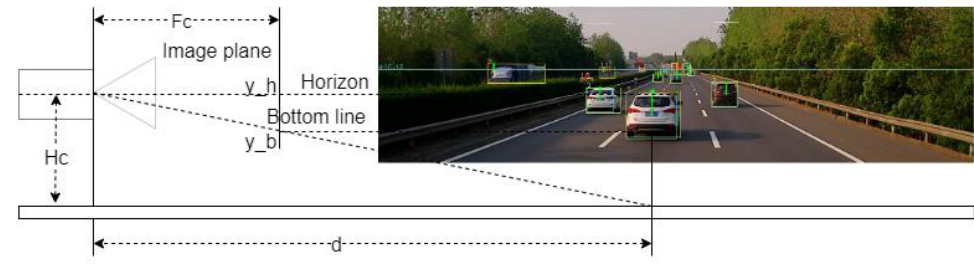
Figure 3. The depth estimator.